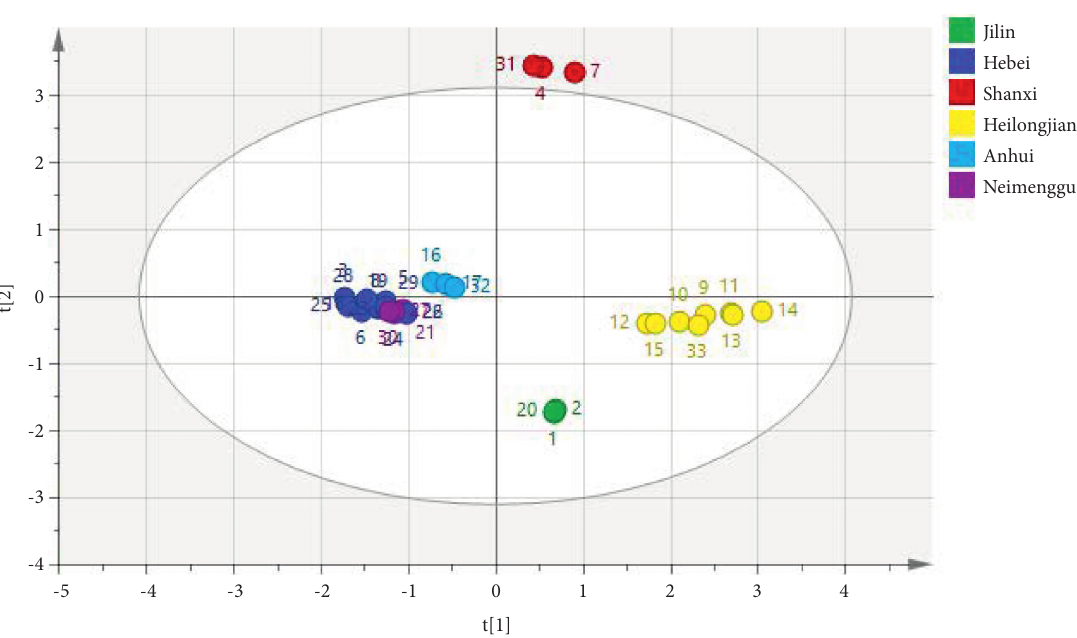
Figure 5: PLS-DA scores for 33 batches of S. divaricata